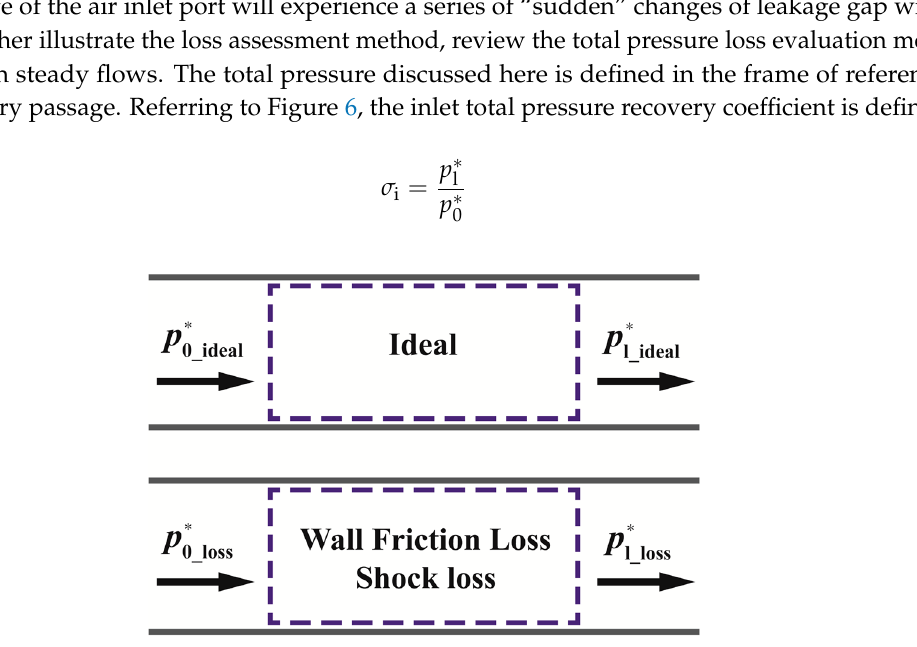
Figure 6. Assessment of inlet total pressure loss.